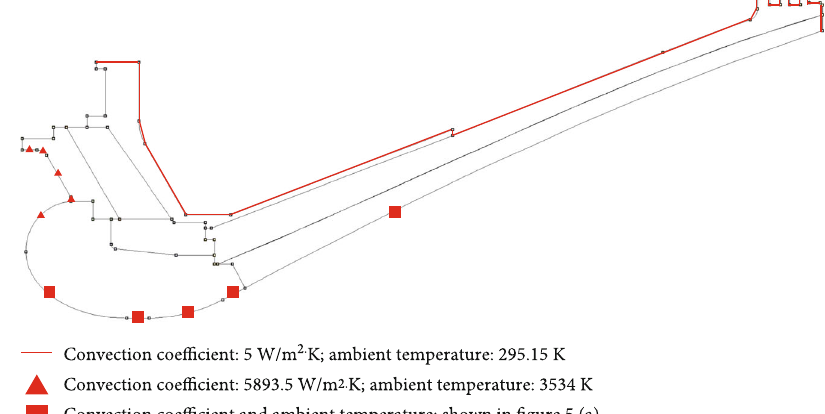
Figure 6: Sketch of thermal boundary.